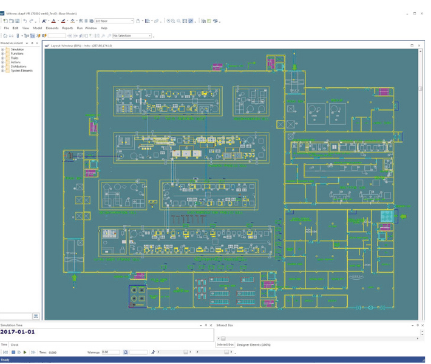
Figure 4: Layout modeling of the target facility using